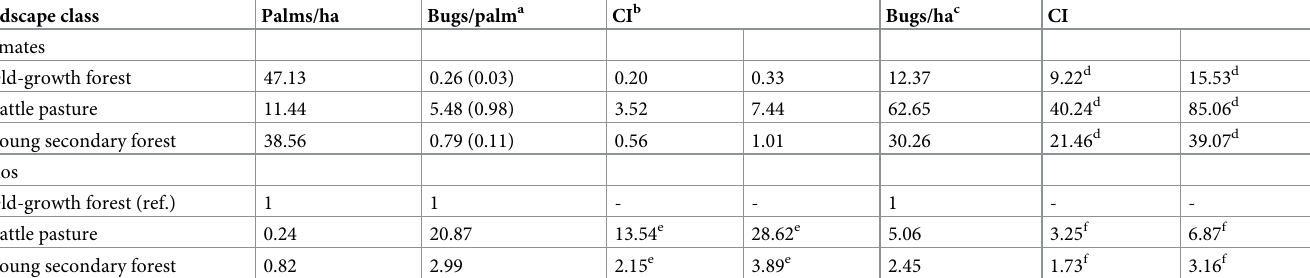
Table 6. Estimates of adult Attalea palm density, mean number of Rhodnius spp. per palm, and expected Rhodnius spp. per hectare (ha) across three landscape clas- ses in two localities of eastern Amazonia. Landscape class